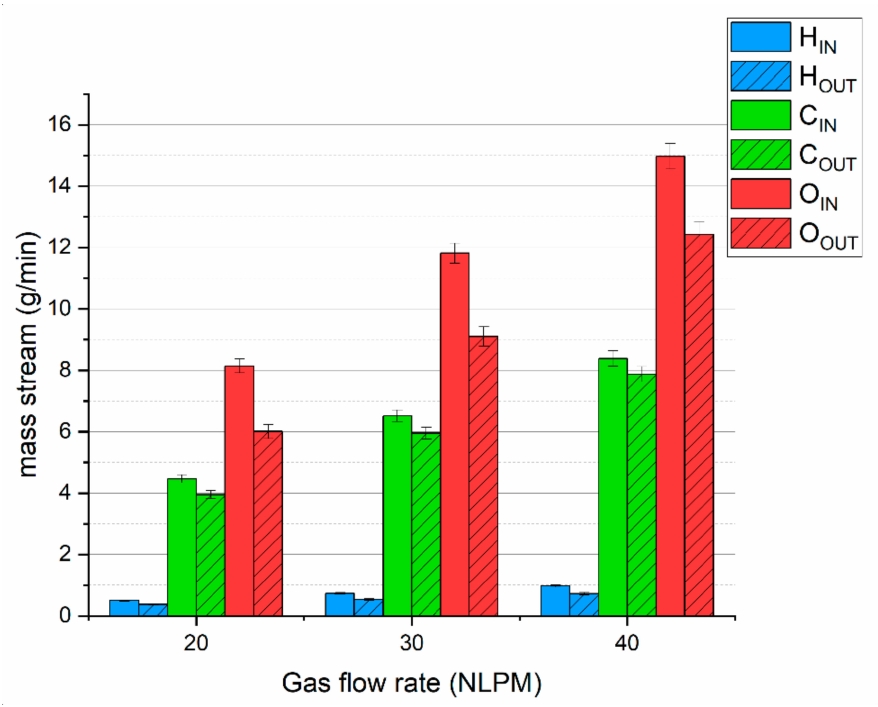
Figure 3. The balance of basic elements of the simulated syngas during MW plasma